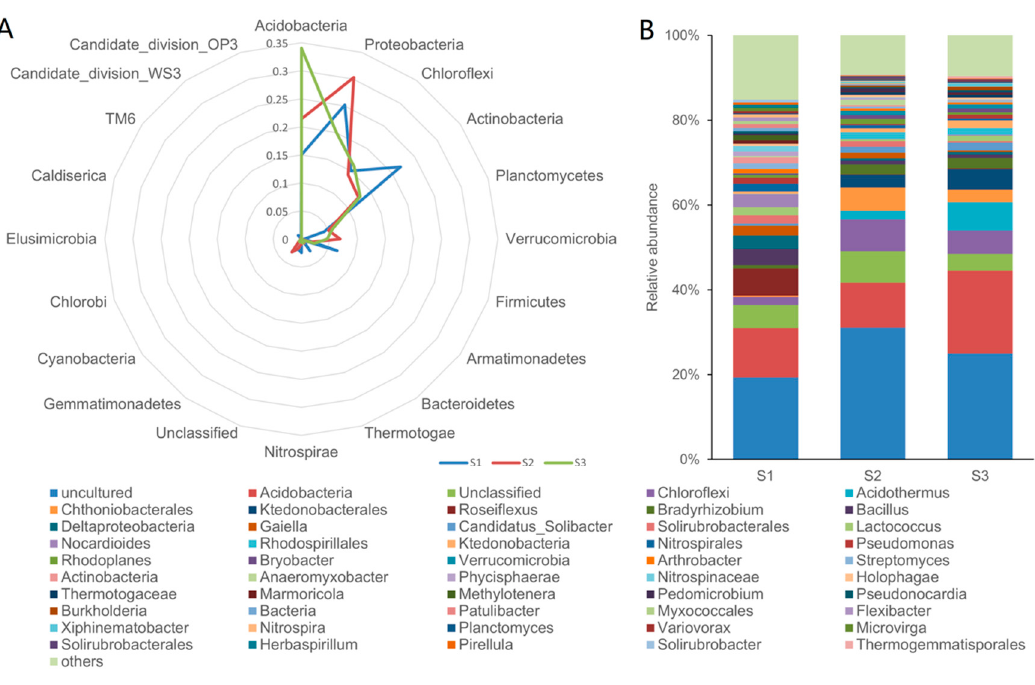
Figure 1. ( A ) Taxonomic distribution of soil samples, phylum distribution of all samples; ( B ) genus distribution of all samples. S1: forest soil; S2: fertilized rubber tree rhizosphere soil from a rubber tree plantation; S3: fertilized bare soil from a plantation. Table 3. MiSeq sequencing results and diversity estimates for each sample.